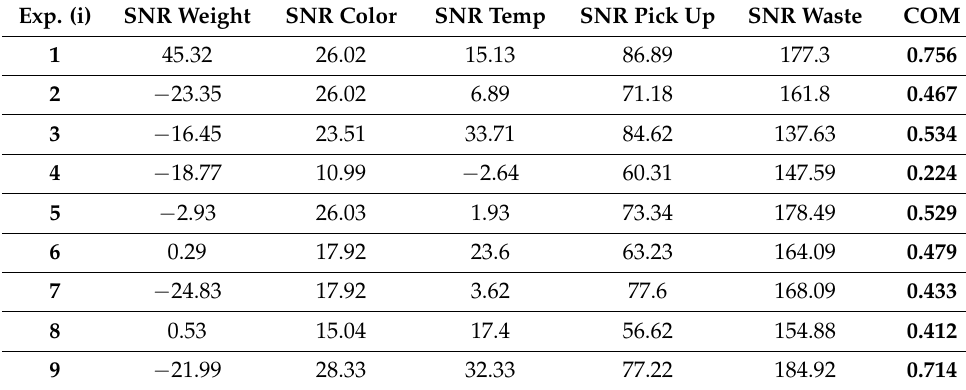
Table 13. The COM value at each experimental